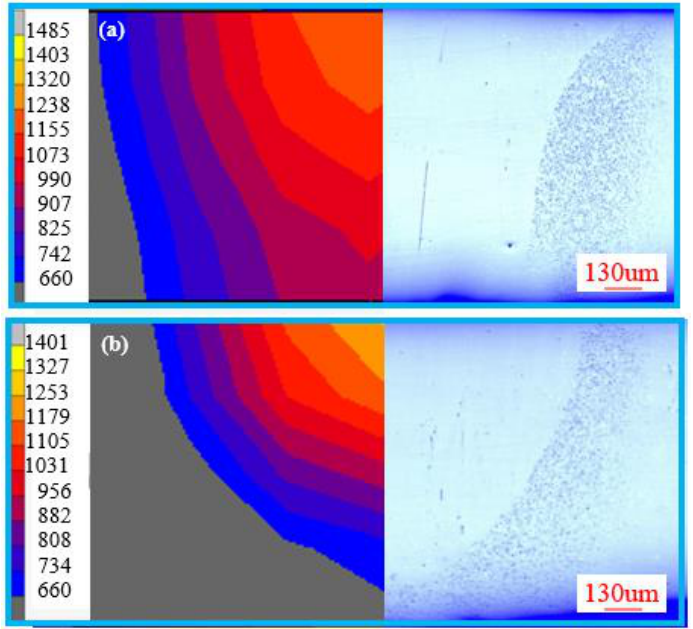
Figure 9. The typical thermal fields’ morphologies and cross section of remelted BMGs obtained by the remelting rate of ( a ) 11 mm/s and ( b ) 13 mm/s.